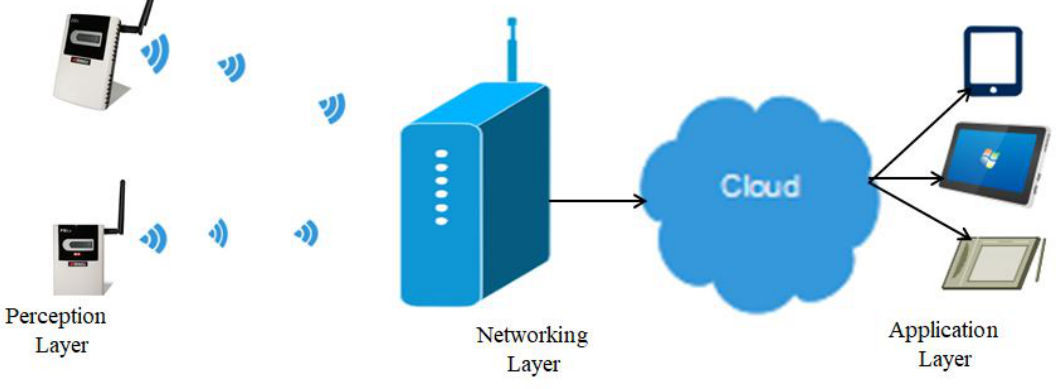
Figure 19. System testing using LoRa